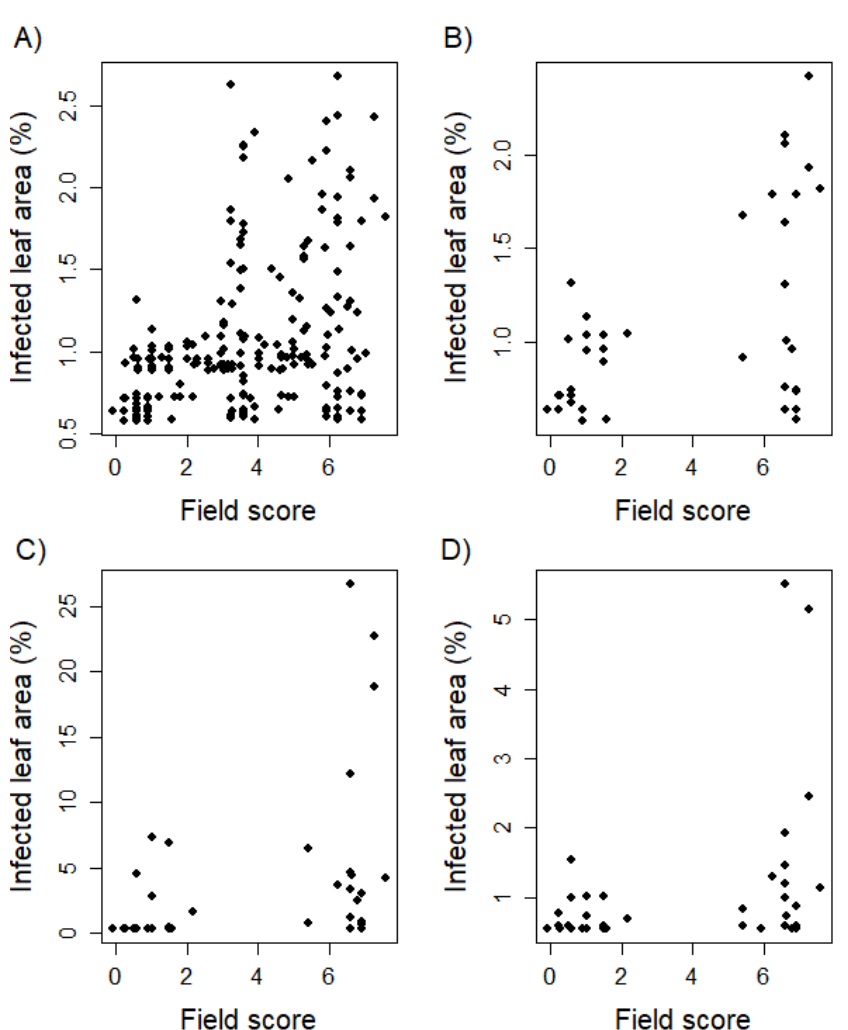
Figure 2. Biplots comparing leaf rust resistance of juvenile plants with adult plants phenotyped in the field environment. Phenotyping in the field was realized following an ordinal scale of increasing infestation from 1 to 9. Phenotypic data was statistically adjusted applying a linear mixed model resulting in a broaden score range. The whole genotype set was examined within greenhouse trials as two leaf seedlings (EC 12; A ). In addition, a limited set of 40 genotypes was tested 10 days (EC 12; B ), 5 weeks (EC 19; C ), and 10 weeks (EC 25; D ) after sowing. Table 6. Pearson correlation of leaf rust scores between a single environment and the corresponding serial mean except this examined environment. The number of overlapping genotypes is given in brackets.